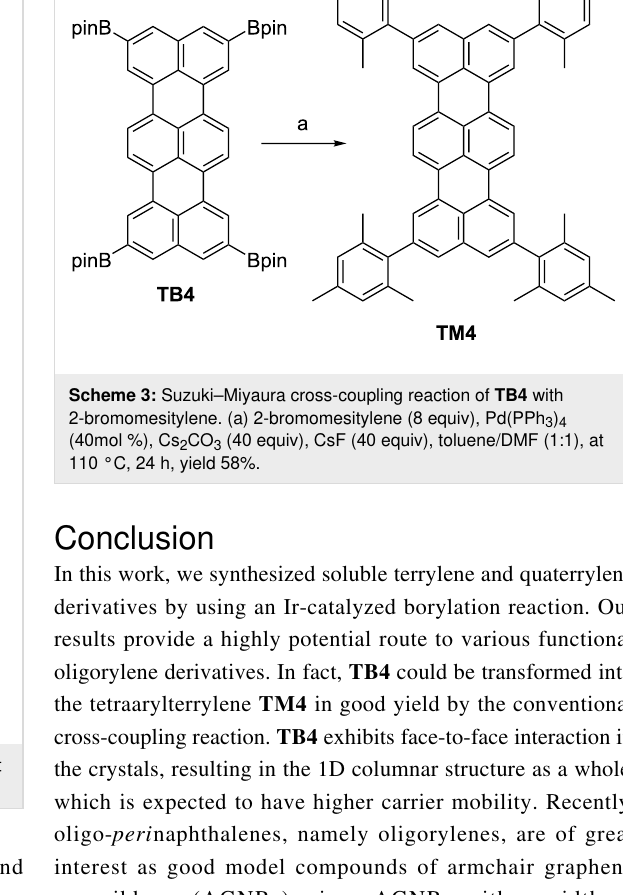
The calculated HOMO levels of –4.29 eV for TB4 and –4.13 eV for QB4 are pretty high among electron-rich com- pounds. Thus we tested the stability of TB4 and QB4 under